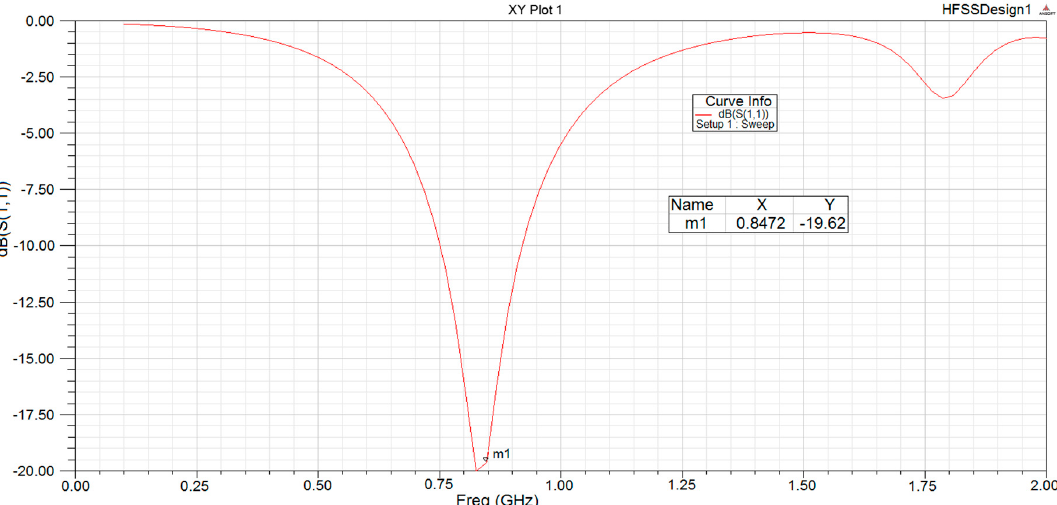
Figure 6. Simulated performance of the antenna.